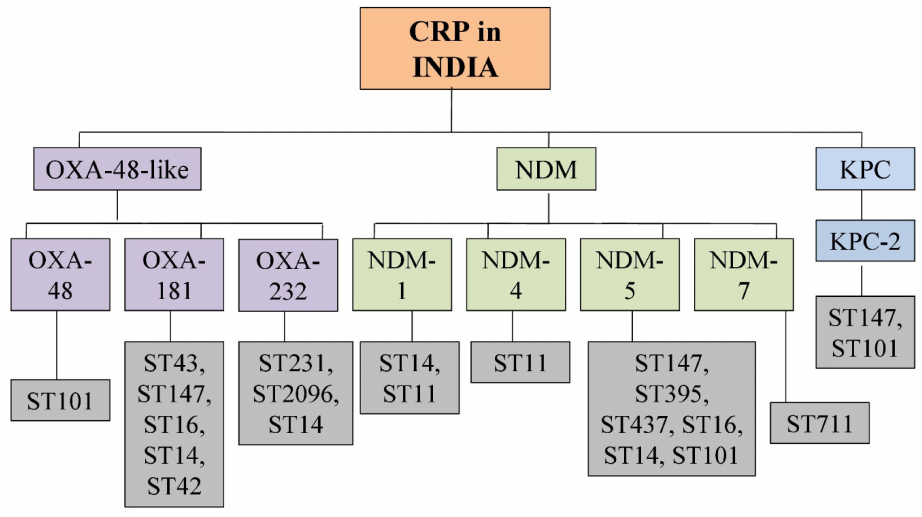
Figure 4. Distribution of carbapenemase genes circulating in India. CRP—carbapenem-resistant